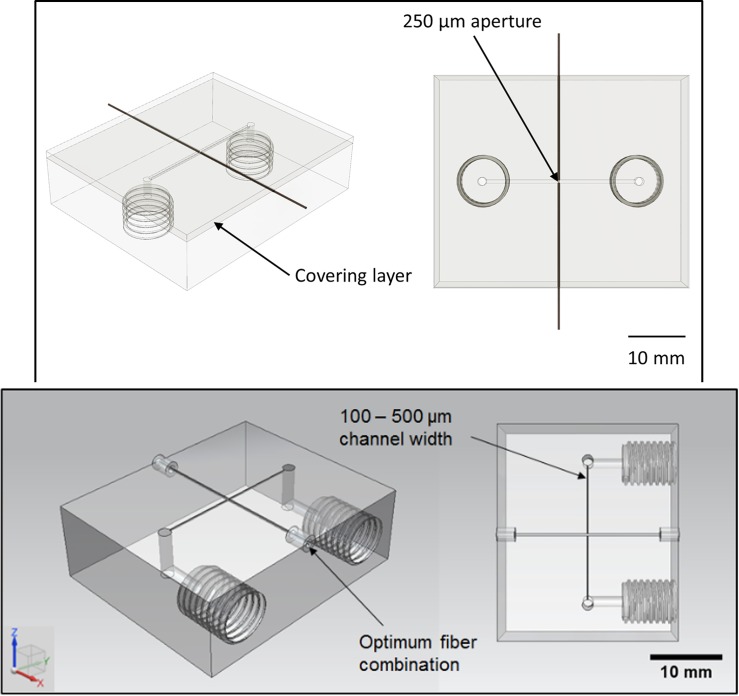
Schematic of the first reported example of a UV-vis UAM reactor cell [4].